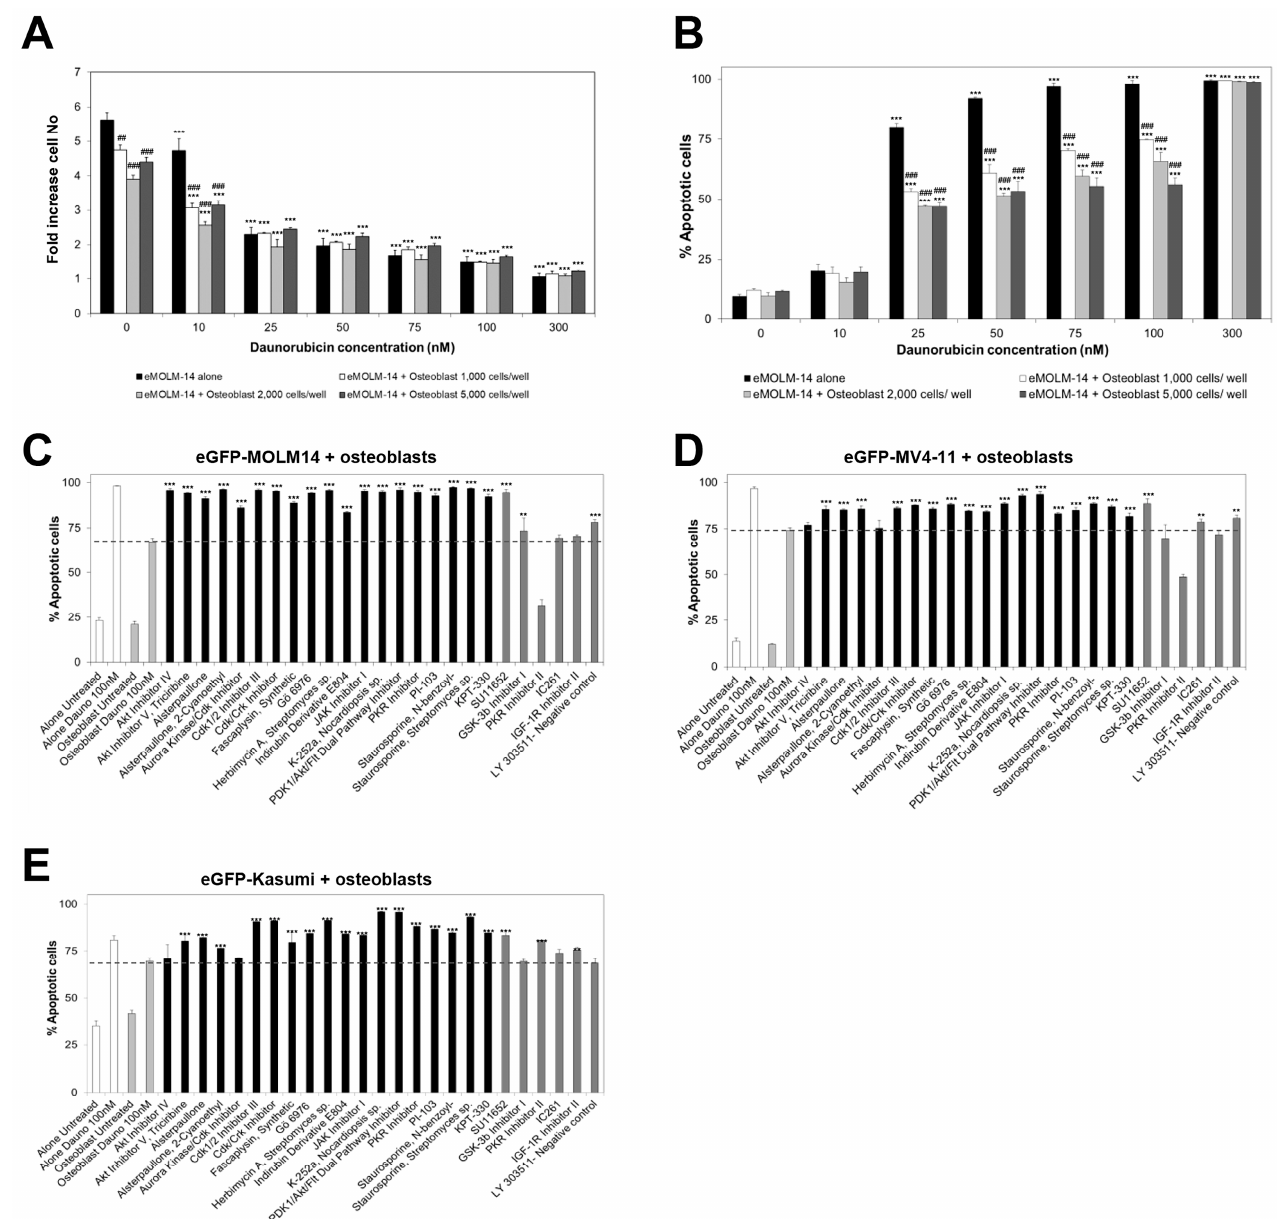
Figure 6. Analysis of the cytotoxic effects of the combination of daunorubicin with the hit compounds identified in the initial drug screening on eGFP–AML cells in co-culture with osteoblasts. The initial optimization of seeding numbers of osteoblasts per well in 96 well plates in co-culture with eGFP–MOLM-14 cells leading to protection against therapeutic drugs, which was tested by measuring the impact of daunorubicin on proliferation ( A ) and the levels of apoptosis ( B ) in eGFP–MOLM-14 cells. In subsequent co-culture experiments, 2000 osteoblasts were seeded per well. A percentage of apoptotic eGFP–MOLM-14 ( C ), eGFP–MV4-11 ( D ), and eGFP–Kasumi ( E ) cells cultured alone (white bars) or in the presence of osteoblasts (light grey bars) when left untreated or when treated with 100 nM daunorubicin. Co-cultures were also treated with 100 nM of daunorubicin in combination with the drugs indicated in the x axis. Black bars indicate hit compounds previously identified in our screening using eGFP–MOLM-14, and dark grey bars, compounds discarded as efficacious in that screening. ** p < 0.01; *** p < 0.005 ANOVA test versus untreated cells under the same culture conditions. ## p < 0.01; ### p < 0.005 ANOVA test versus the same treatment in monoculture of AML